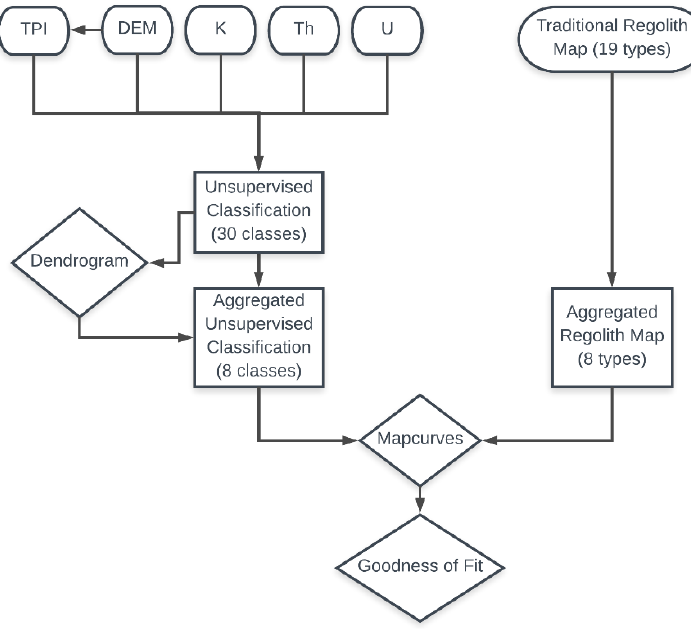
Figure 2. Flowchart illustrating the methodology workflow.